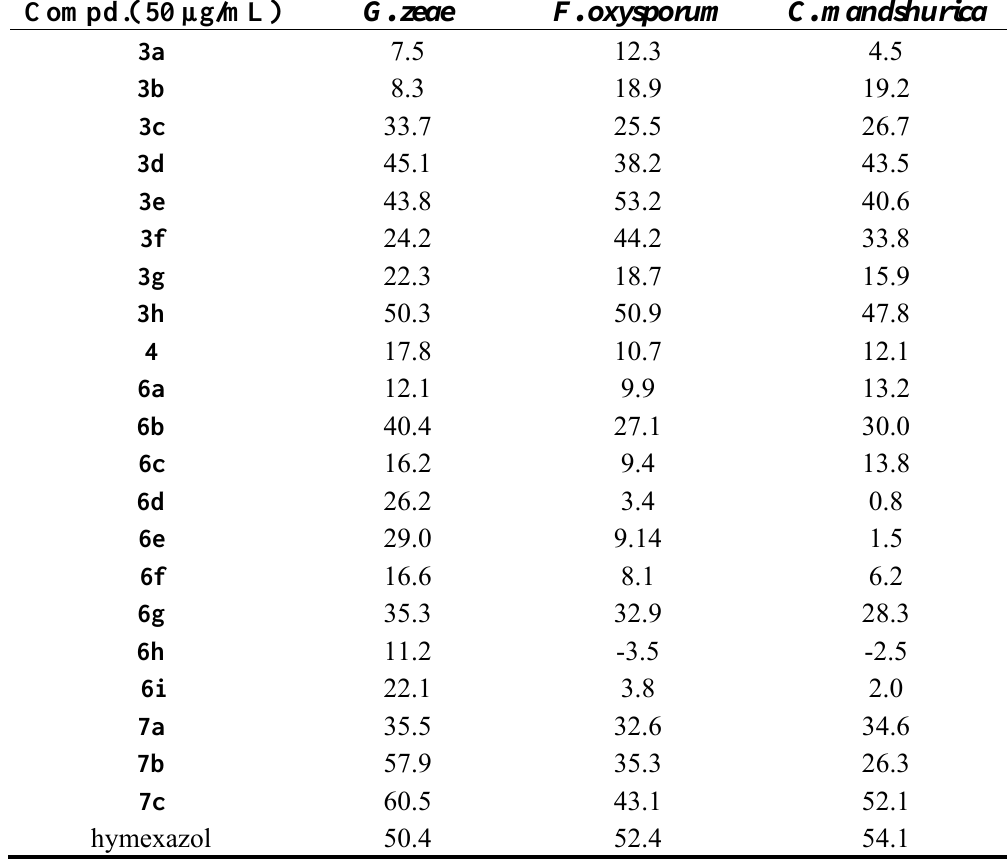
Table 1. Inhibition effects of pyridazine derivatives on phytopathogenic